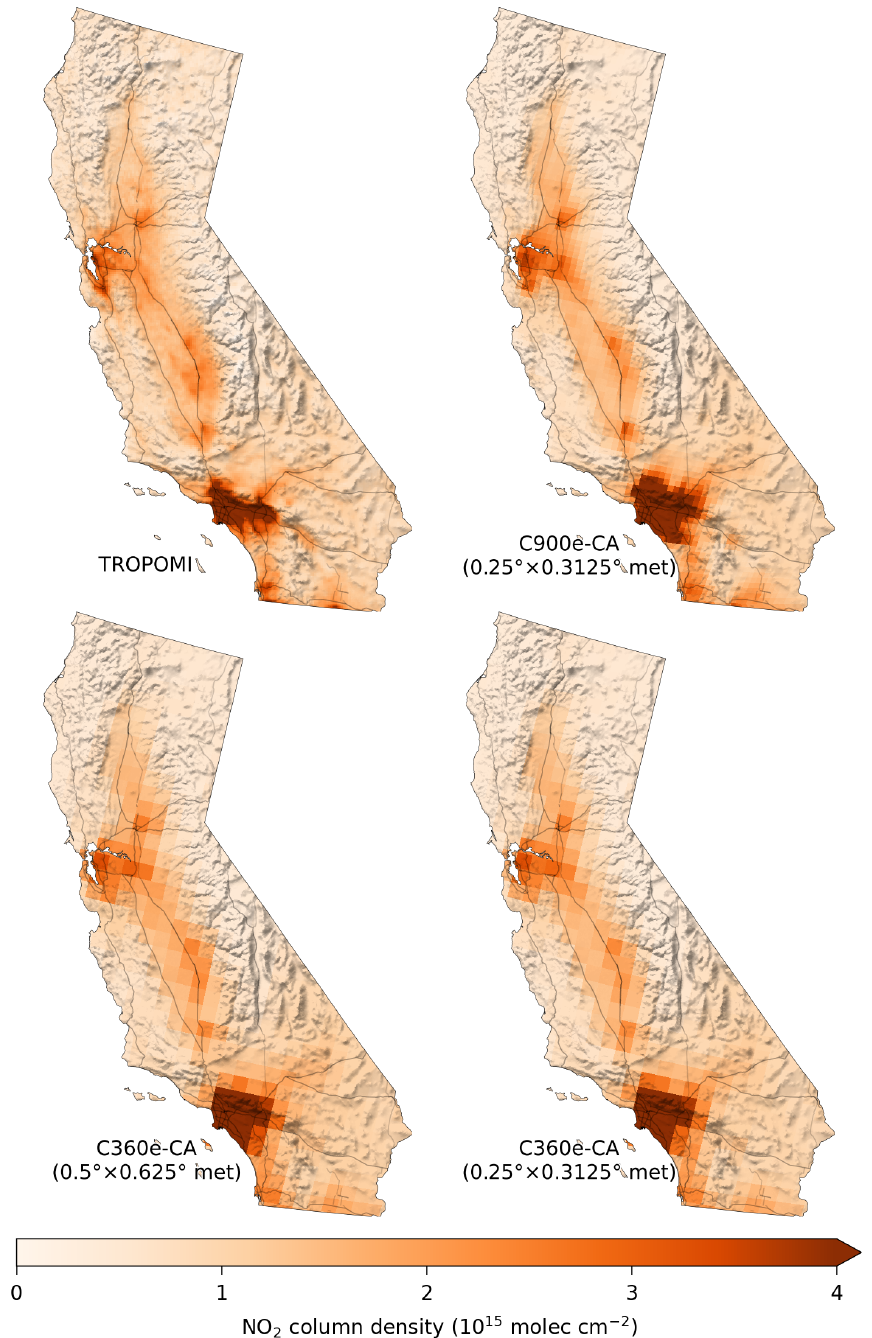
Figure D1. Mean tropospheric NO 2 column densities from TROPOMI, C900e-CA, C360e-CA with 0.25 ◦ × 0.3125 ◦ meteorological data, and C360e-CA with meteorological data downscaled to 0.5 ◦ × 0.625 ◦ .